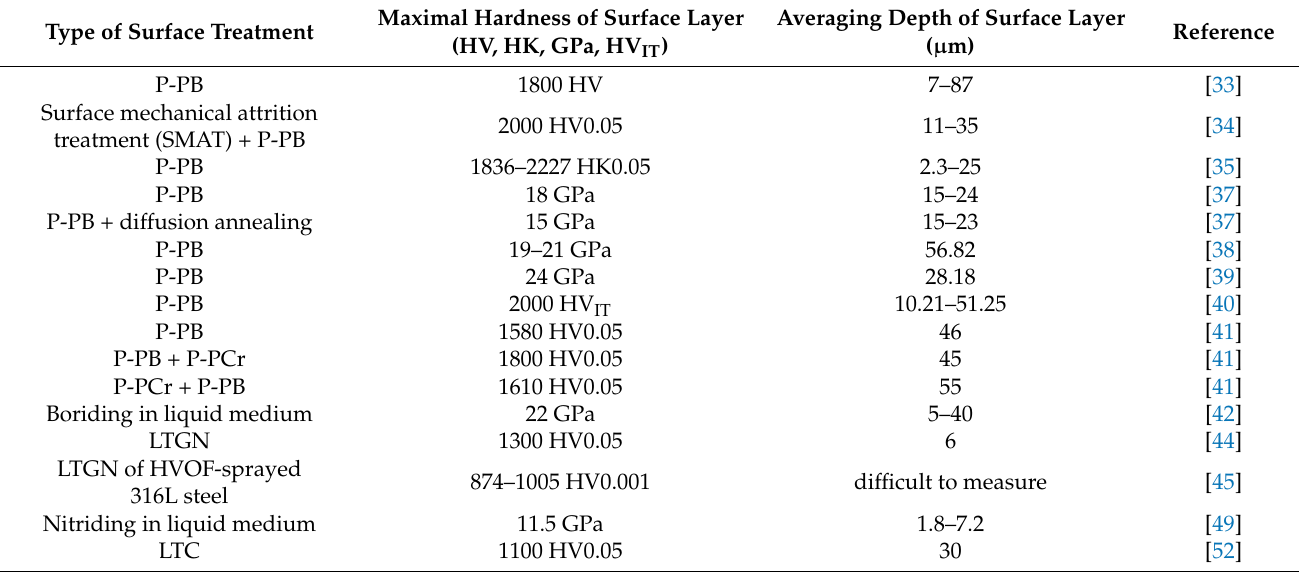
Table 2. Maximal hardness values and averaging depths of the surface layers measured after the surface treatment of austenitic steel using various thermochemical